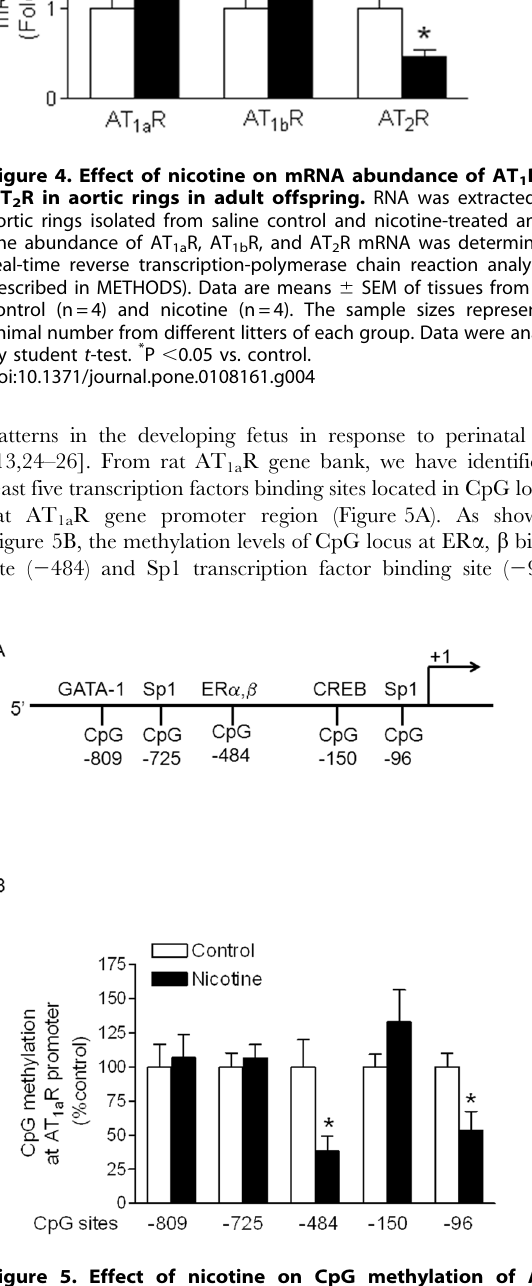
Figure 5. Effect of nicotine on CpG methylation of AT 1a R promoter in aortic rings in male offspring. Aortic rings were freshly isolated from male adult offspring that had been exposed in utero to saline control or nicotine. DNA was isolated and methylation levels were determined by methylation-specific real-time PCR. Data are means 6 SEM of tissues from saline control (n=4) and nicotine (n=4). The sample sizes represent the animal number from different litters of each group. Data were analyzed by student t -test. * P , 0.05 vs. control.